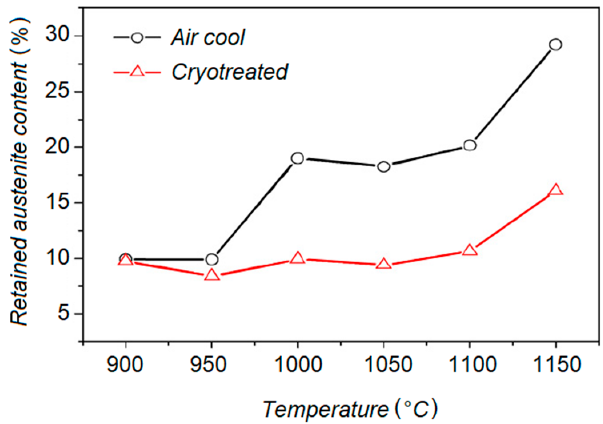
Materials 2019 , 12 , x FOR PEER REVIEW Figure 7. The content of retained austenite at different heat-treated states (heated for 0.5 h) [66]. Figure 7. The content of retained austenite at di ff erent heat-treated states (heated for 0.5 h) [66].